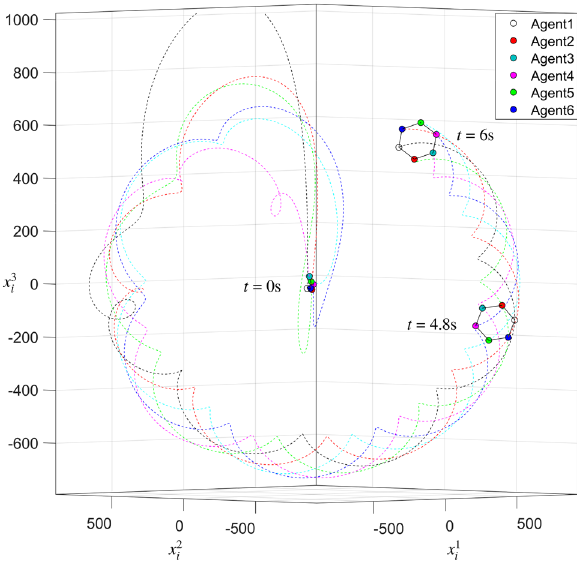
Figure 2. State trajectories of all agents without interaction